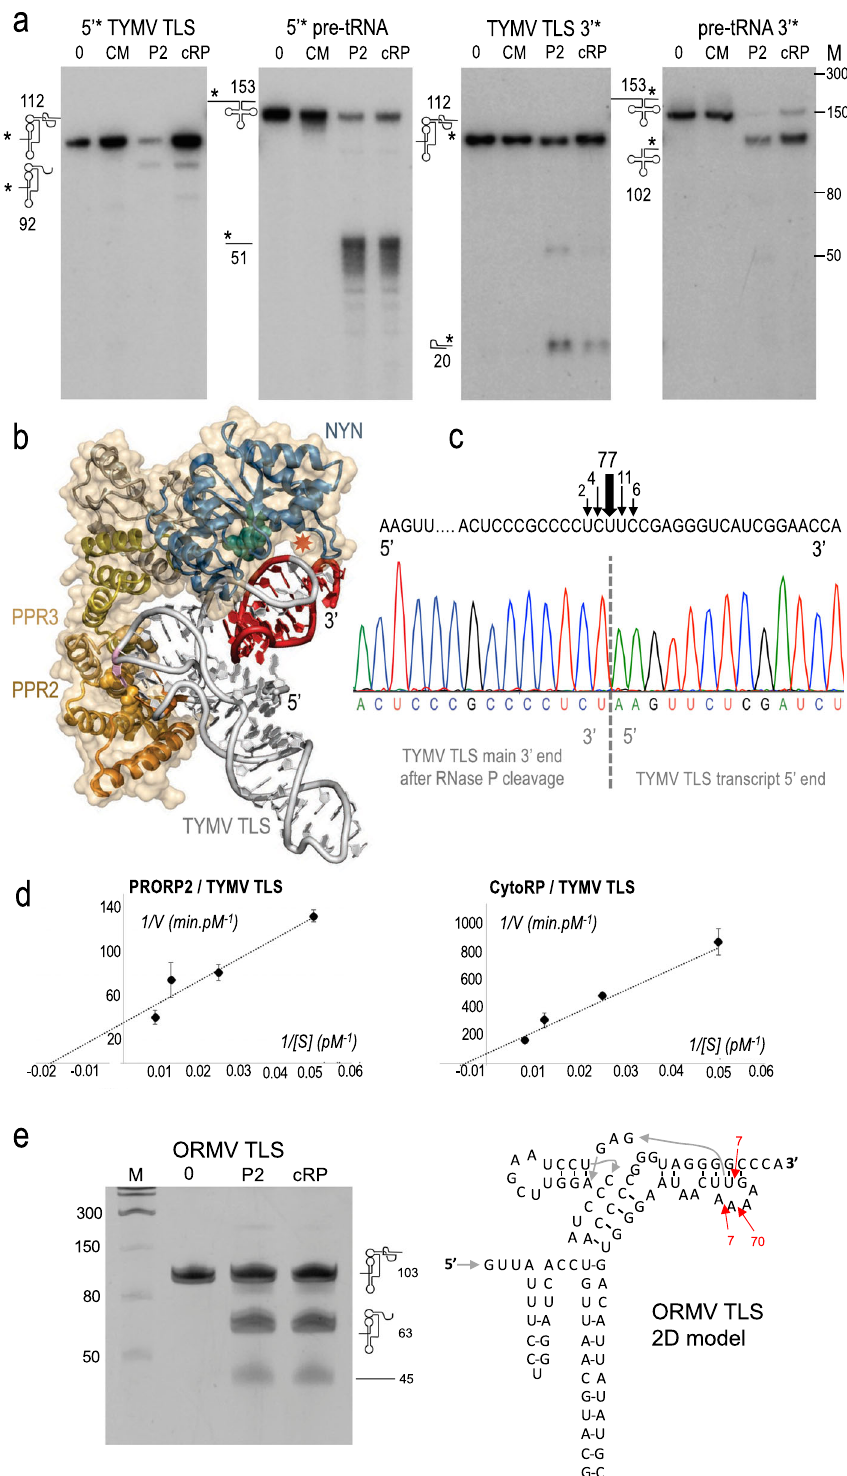
health, or environmental impact 22 . Such a risk is not expected with the CytoRP technology, as it does not depend on the insertion of pathogen-derived sequences into the plant genome. Furthermore, it can be expected that the chance for a resistance-breaking variant to arise in the viral population is low, because the RNase P cleavage sites in TLS, e.g. that of TYMV